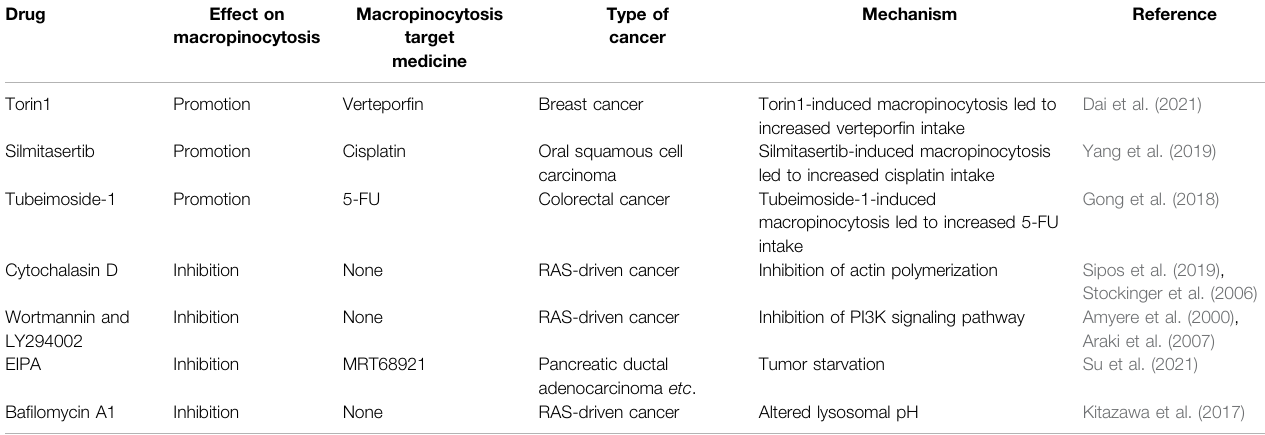
TABLE 1 | Examples of use of macropinocytosis in cancer therapy.